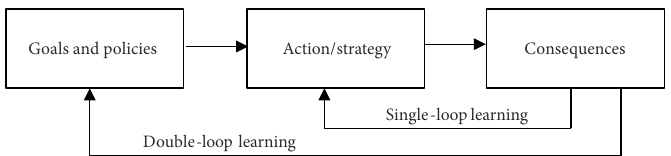
Single-loop learning Double-loop Figure 1. The concept of single and double-loop learning (Adapted from Dunlop (2010))